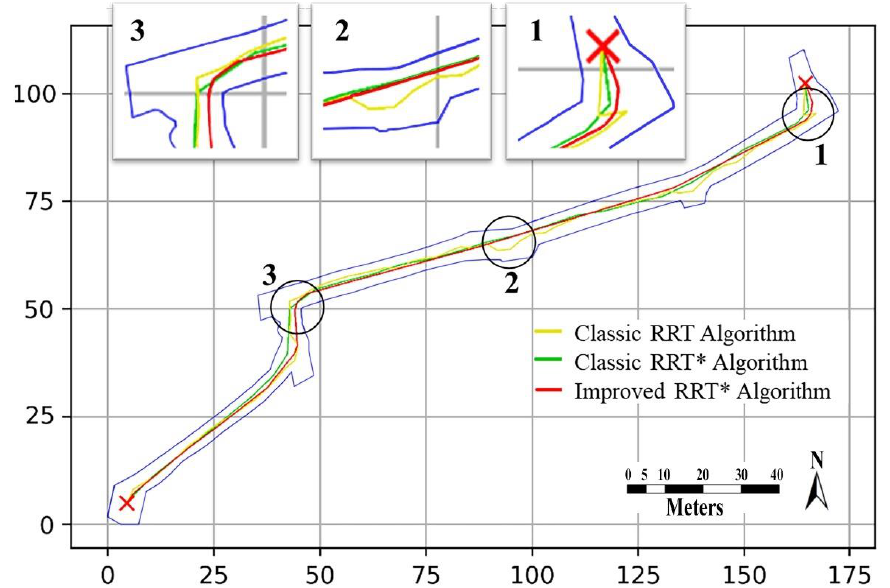
Figure 14. The simulation results.